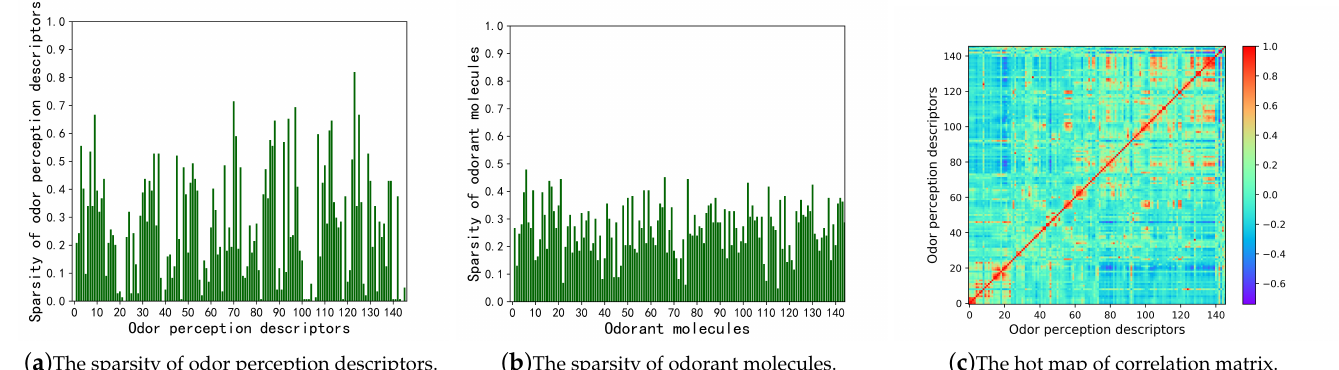
( c ) The hot map of correlation matrix. Figure 5. The statistics of the Dravnieks odor perceptual dataset. The numbers on the horizontal axis in ( a ) and ( c ) represent the 146 odor perception descriptors. The numbers on the horizontal axis in ( b ) represent the 144 odorant